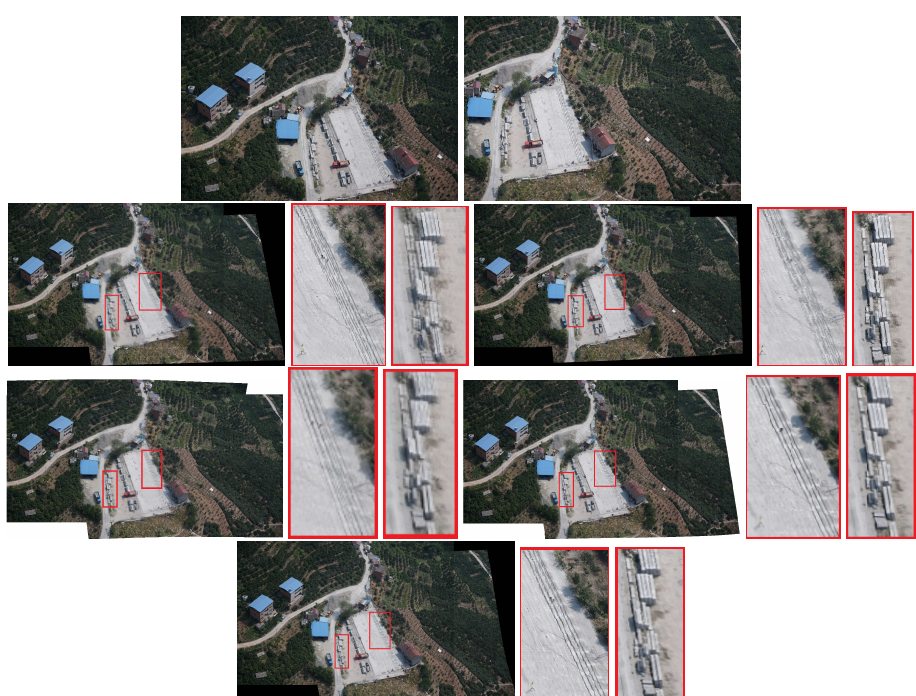
Figure 5. Qualitative comparison on UAV image mosaic. The first row is the two images to be stitched. The second and third rows are the stitching results of Autostitch [4], AANAP [41], SPHP [40], and PT [54]. Our result is shown in the last row. Red boxes highlight the ghostly parts.